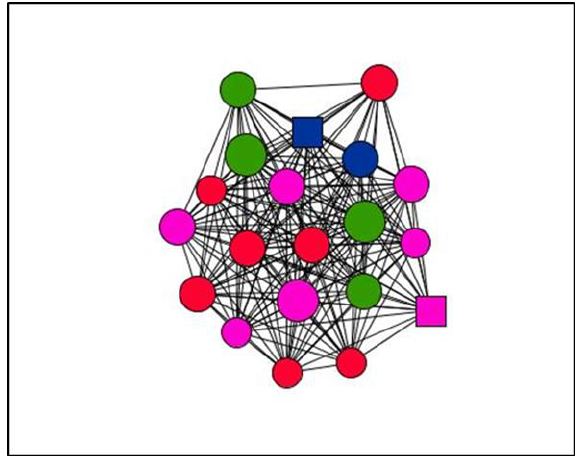
Figure 2. Graph Case 24. Woman, 53 years old, 3 years with chronic pain. Int. J. Environ. Res. Public Health 2018 , 15 , x FOR PEER REVIEW